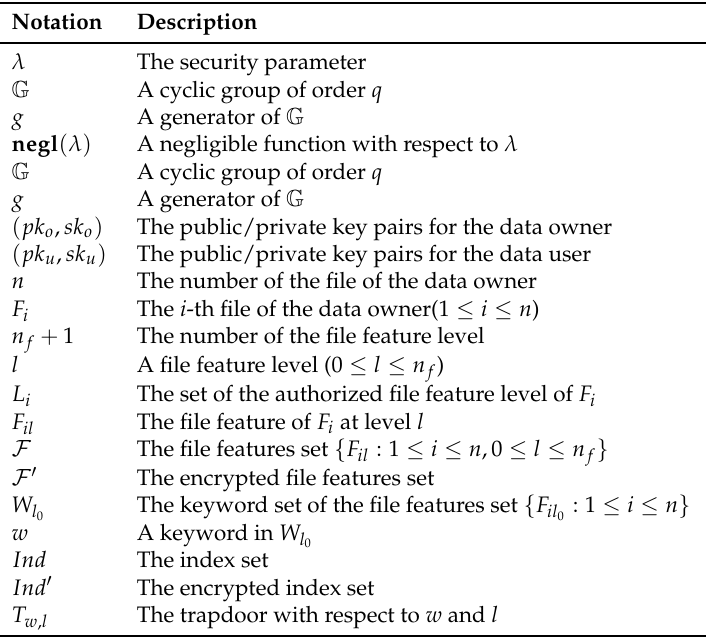
Table 2. Summary of